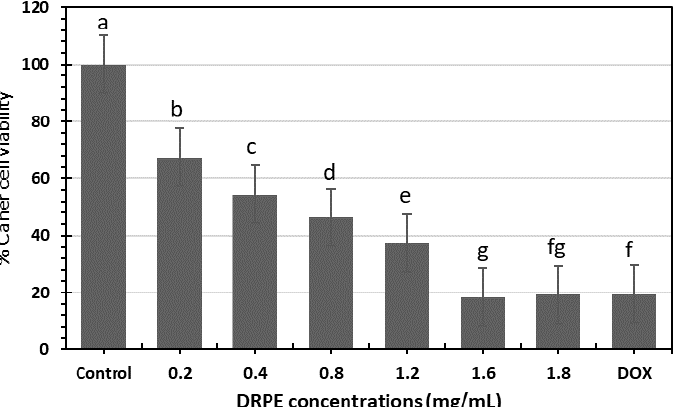
Figure 11. Histogram of the % viability of breast cancer cells affected by DRPE at different concentra- tions compared to doxorubicin. Lowercase letters above the columns indicate significant differences at a 5% probability